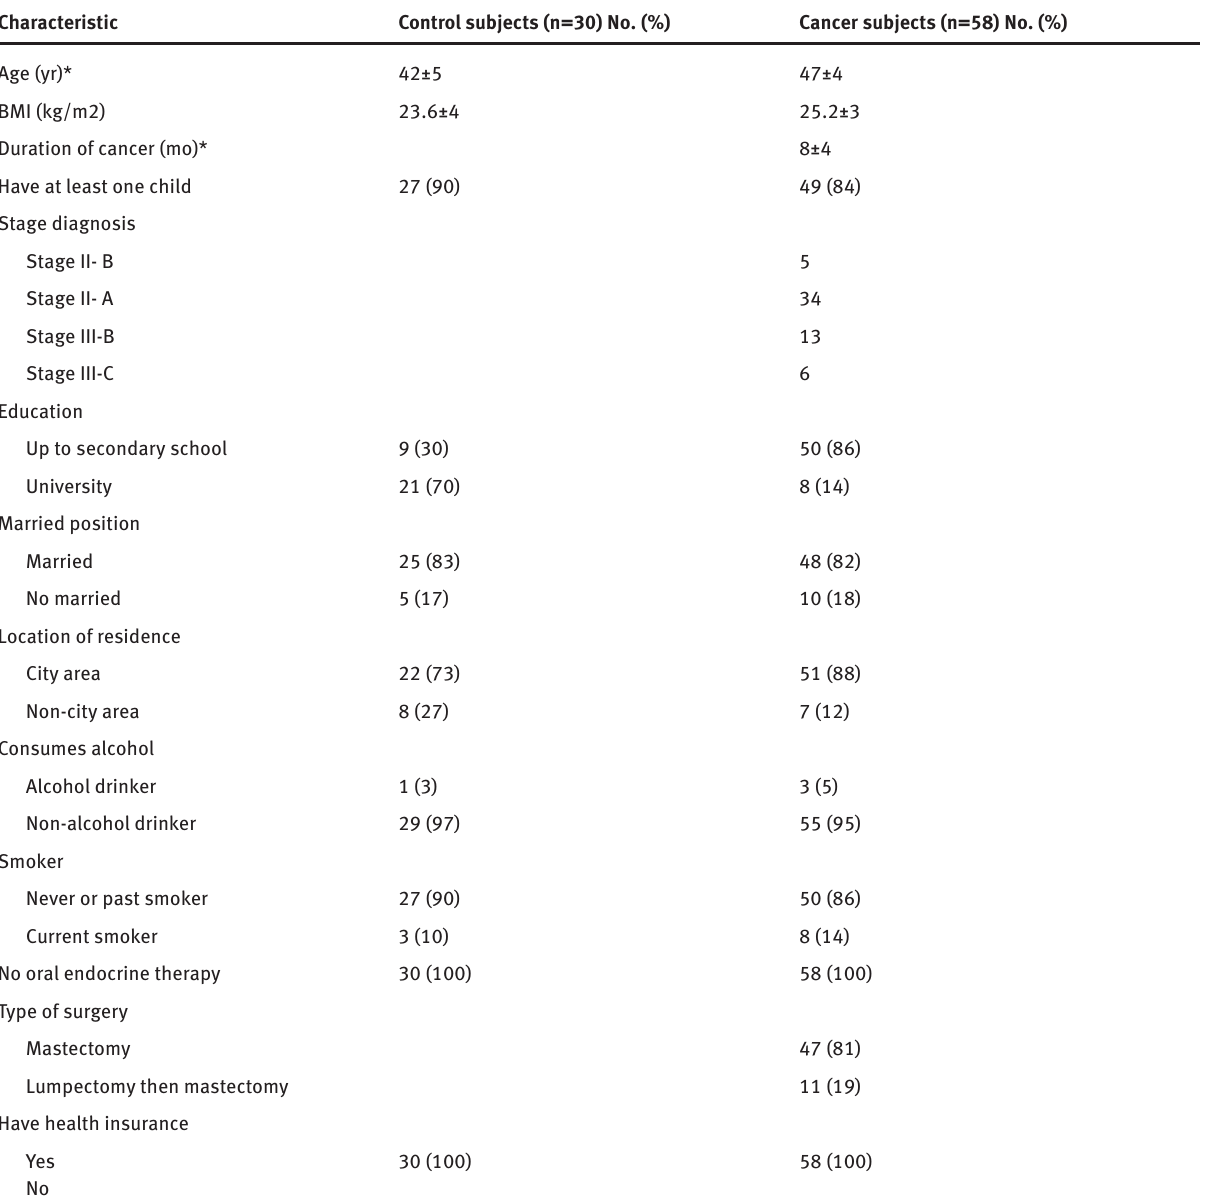
Table 1: Clinical and demographic charecteristics of study subjects